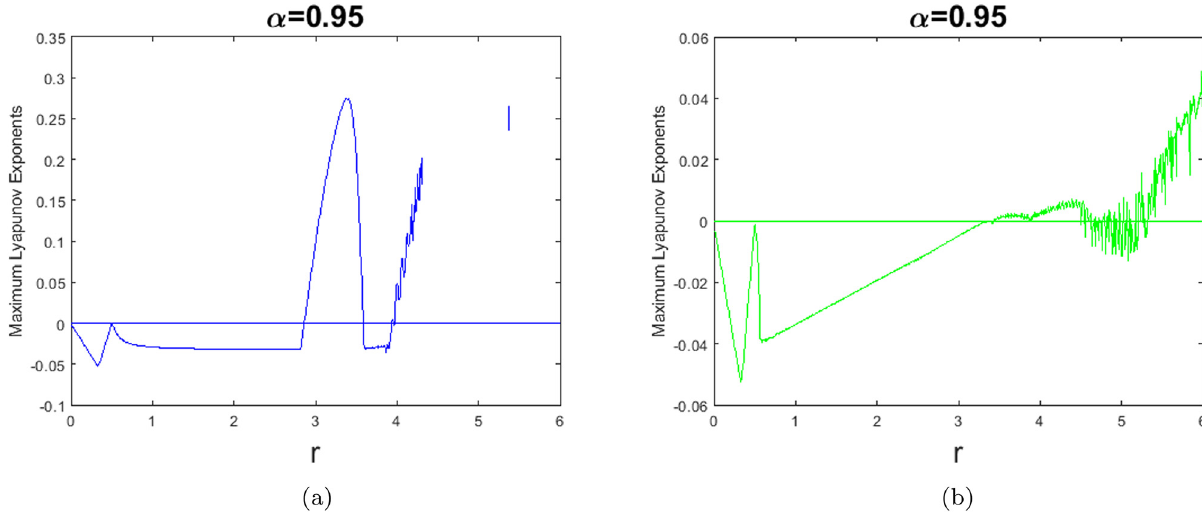
Figure 7: Maximum Lyapunov exponents corresponding to: ( a ) Figure 5 ( a ) and ( b ) Figure 6 ( a ) .